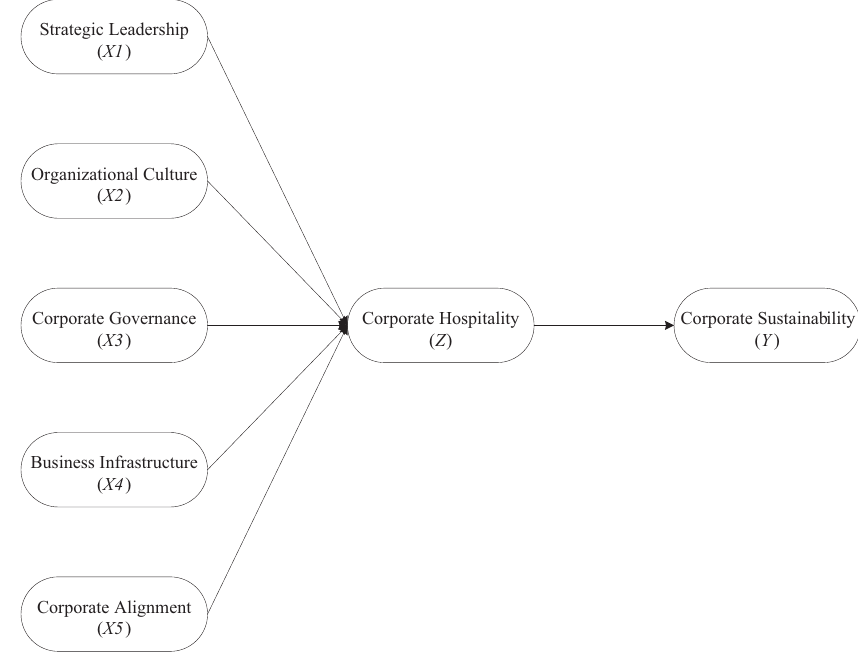
Figure 1. Conceptual